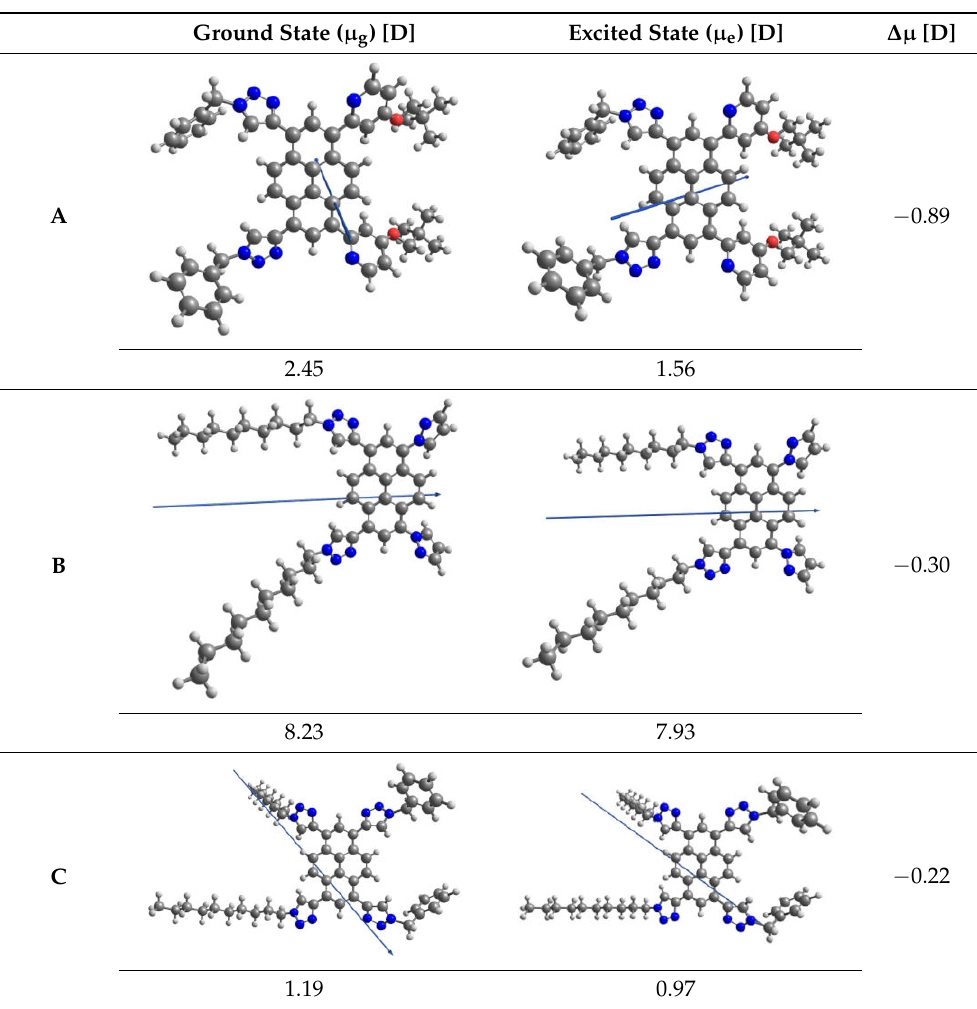
Table 7. Calculated dipole moment B3LYP/6-31G(d,p) for molecules A – C